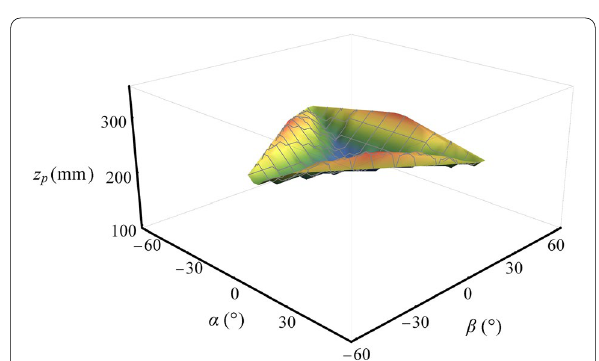
Figure 9 Three-dimensional curve diagram of the